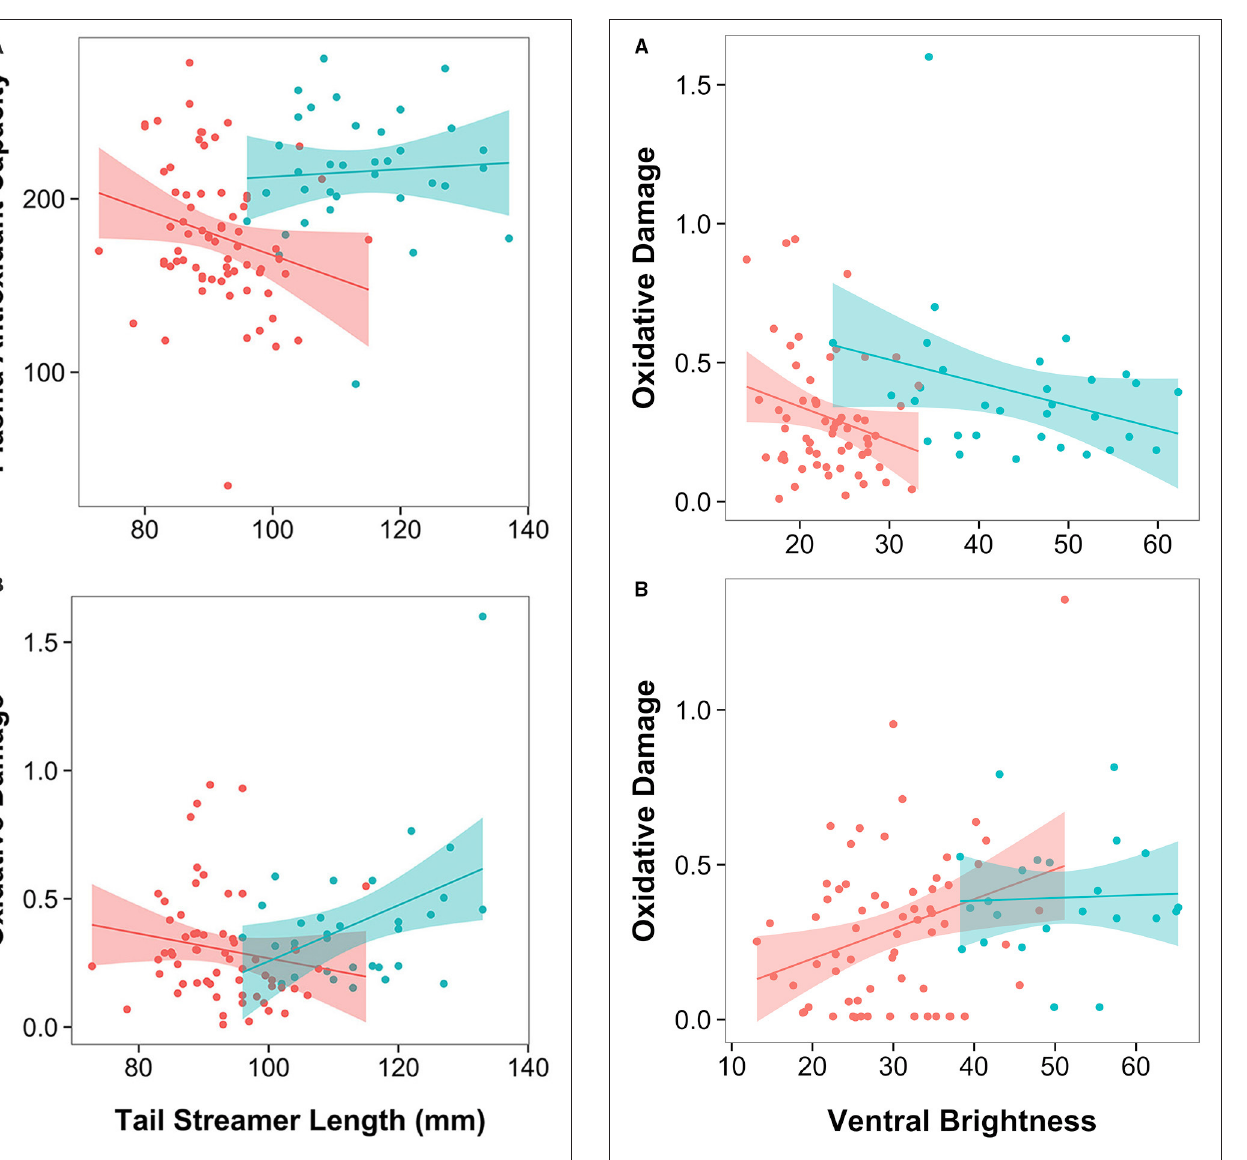
FIGURE 2 | Male tail streamer length is differently associated with measures of oxidative stress in recently diverged populations that differ in signal use. Regressions of tail streamer length on: (A) Plasma antioxidant capacity (mM HOCl neutralized), and (B) oxidative damage (mM H 2 O 2 equivalents) in North American H. r. erythrogaster (red symbols and regression line) and European H. r. rustica (blue symbols and regression line). Shading represents the 95% confidence interval for the linear regression.